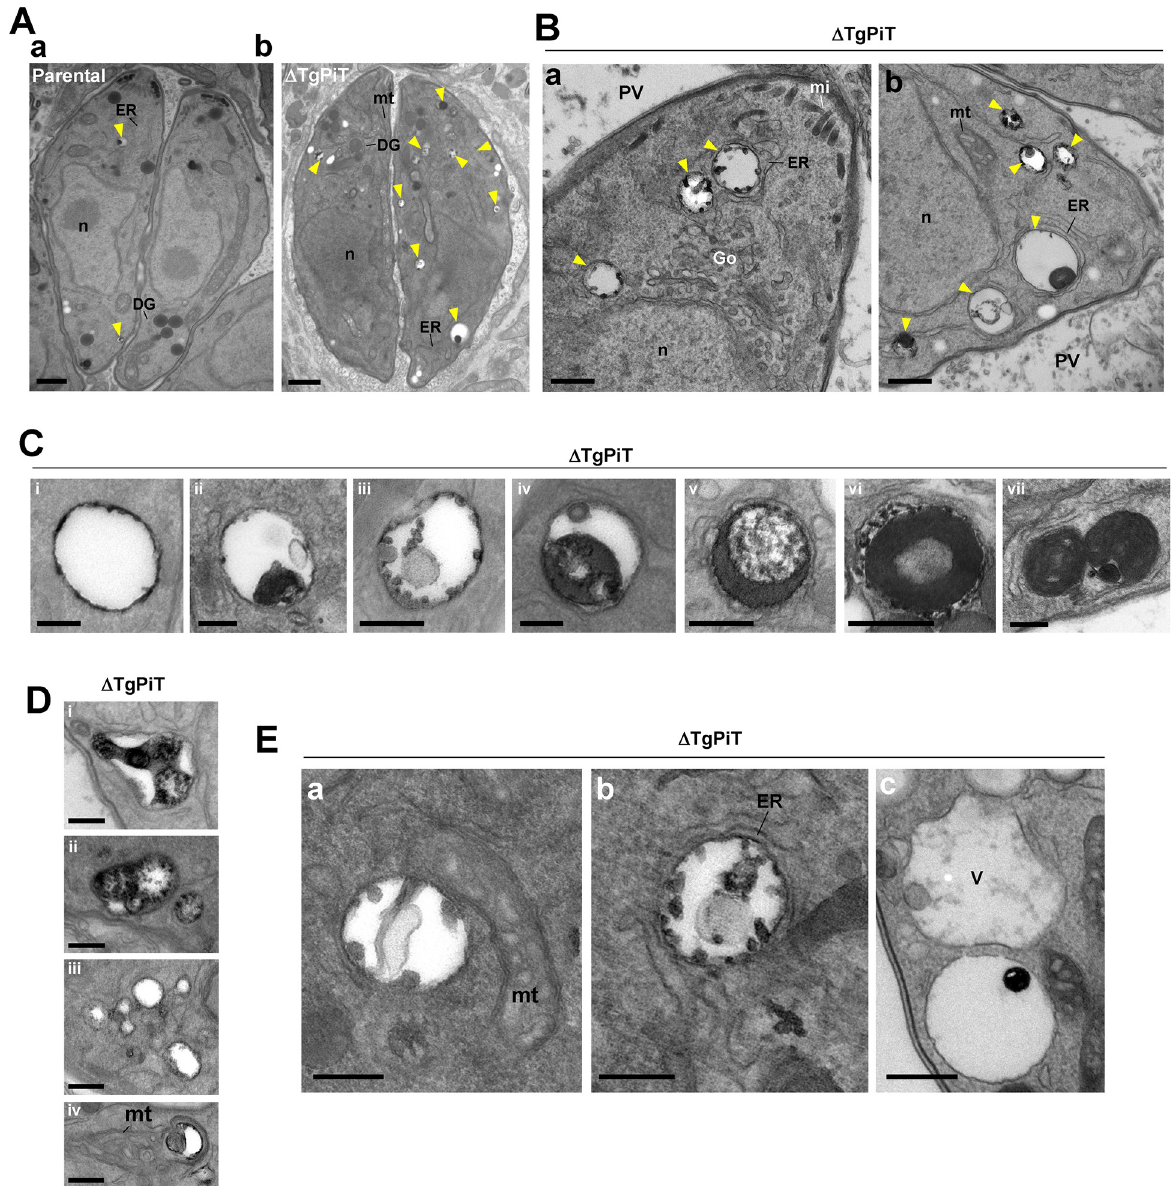
Fig 8. Acidocalcisomes in Δ TgPiT parasites. A. EM of HFF infected for 24 h with parental or Δ TgPiT parasites. Comparison between parental (panel a) and Δ TgPiT (panel b) parasites for acidocalcisome (arrowheads) content. Bars, 500 nm. B. Ultrastructure of acidocalcisomes (arrowheads) in Δ TgPiT parasites, typified by luminal electron-dense inclusions. Bars, 500 nm. C-E. Panel of different acidocalcisomes in Δ TgPiT parasites, showing: in D from panel i to vii increased electron-dense material in the matrix; in E various shape and; in F proximity to other organelles. Bars in D-F, 200 nm. DG, dense granule; Go, Golgi; hc, host cell; m, mitochondrion; mi, microneme; n, nucleus; V, the VAC.